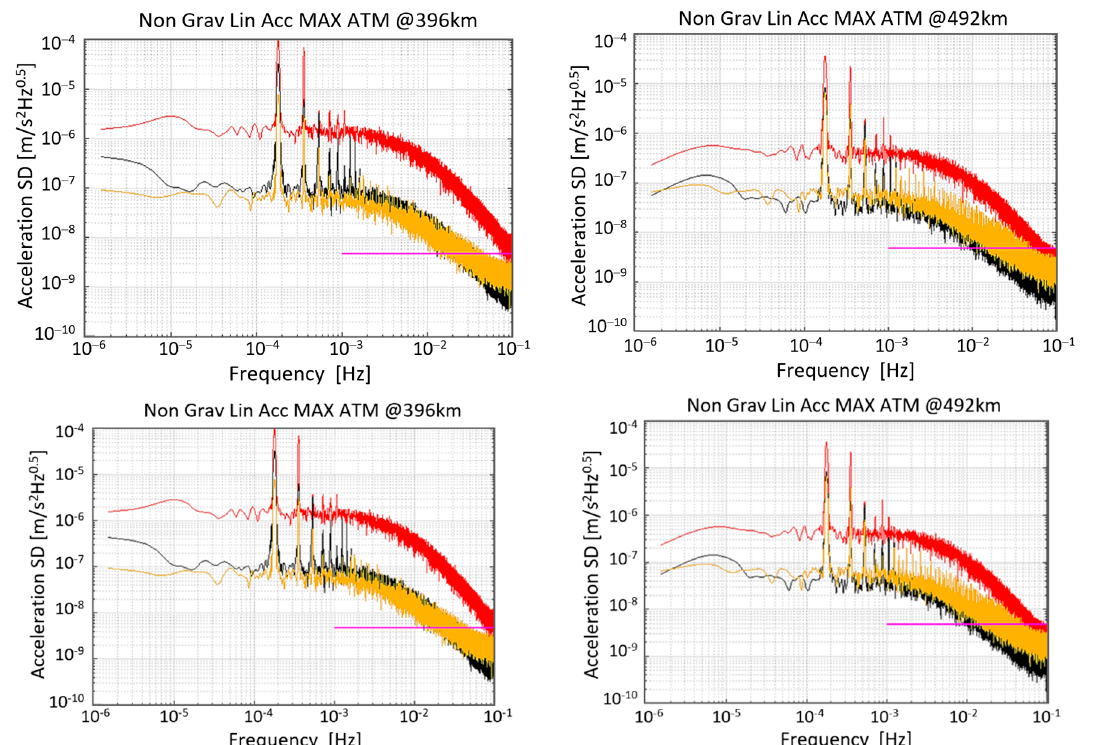
Figure 16. Amplitude spectral density of the drag acceleration components at 396 km and 492 km, computed at the epoch of maximum solar activity with 95th percentile on F 10.7 and A p prediction. The control requirement (magenta horizontal line, taken from Table 4 ′ s control requirement for the spectral densities of the linear accelerations in the MBW) is abundantly exceeded below 50 mHz by all components.